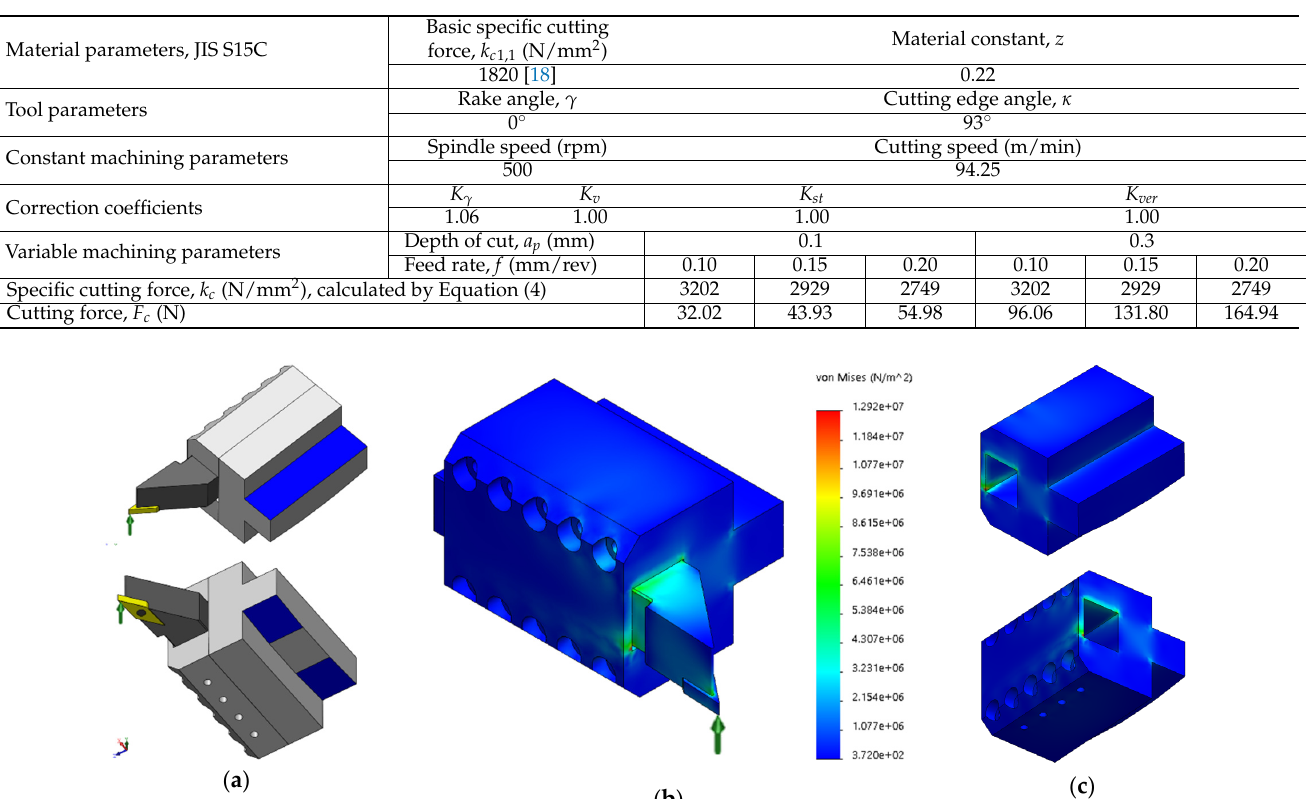
Table 3. The parameters related to the cutting force calculation through Kienzle model.